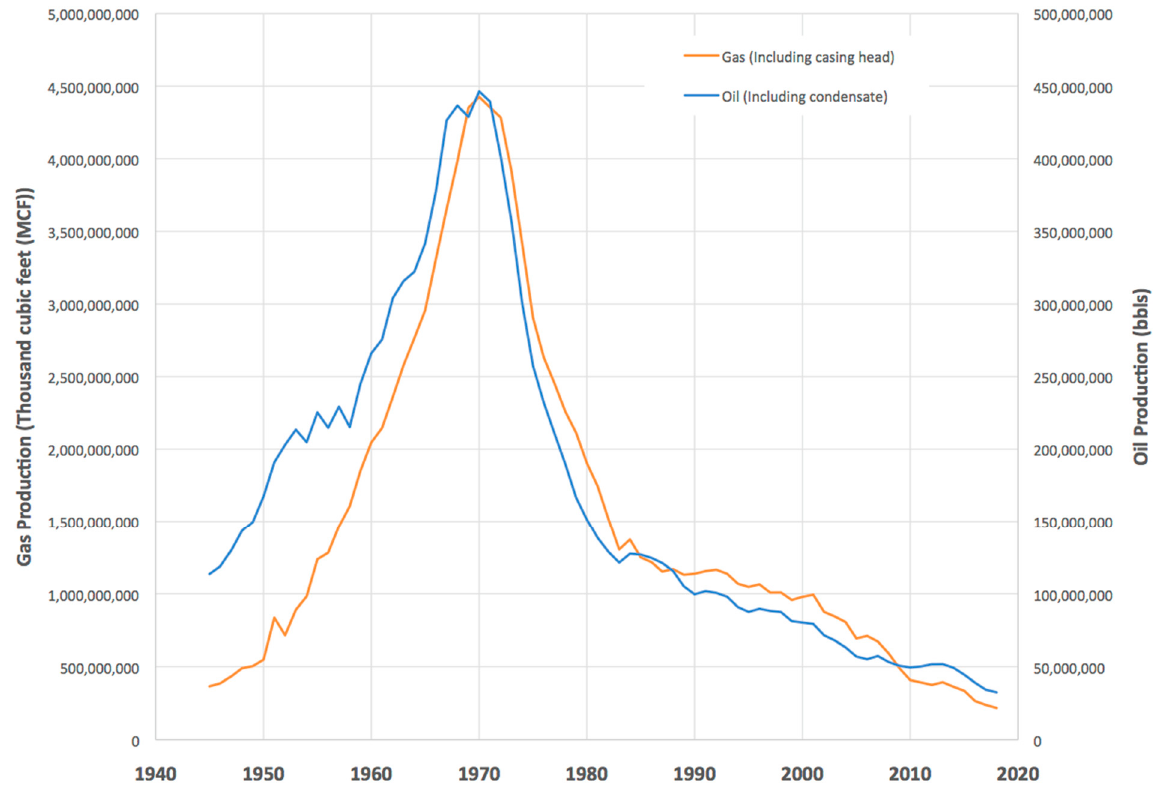
Figure 2. Annual oil and gas production in southern Louisiana between 1945 and 2019. Data source: (http://www.dnr.louisiana.gov/assets/TAD/OGTables/Table03.pdf).